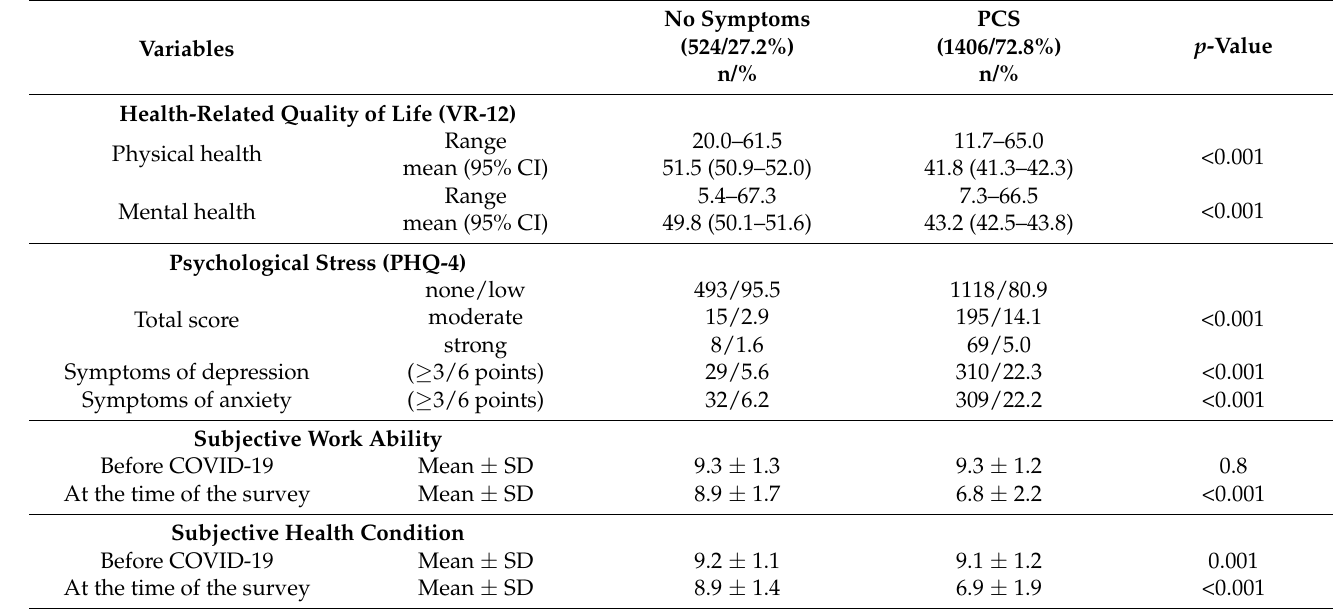
Table 4. Health-related quality of life in participants with symptoms persisting more than 3 months (PCS) vs. no symptoms (n =